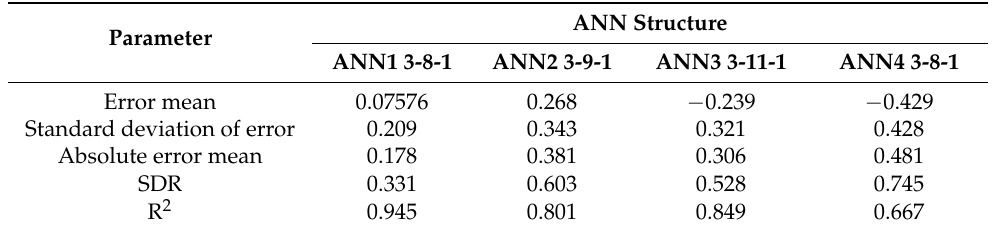
Table 4. Basic regression statistics of the ANNs